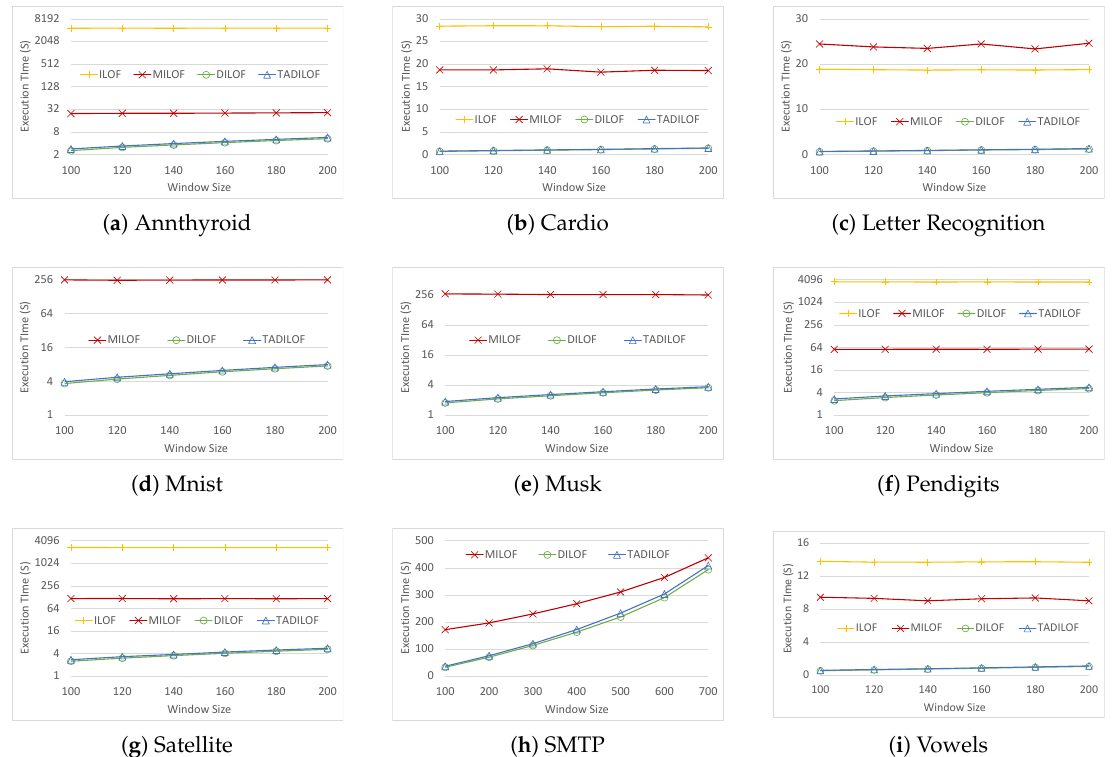
Figure 7. Execution time on various datasets with different window sizes and K =